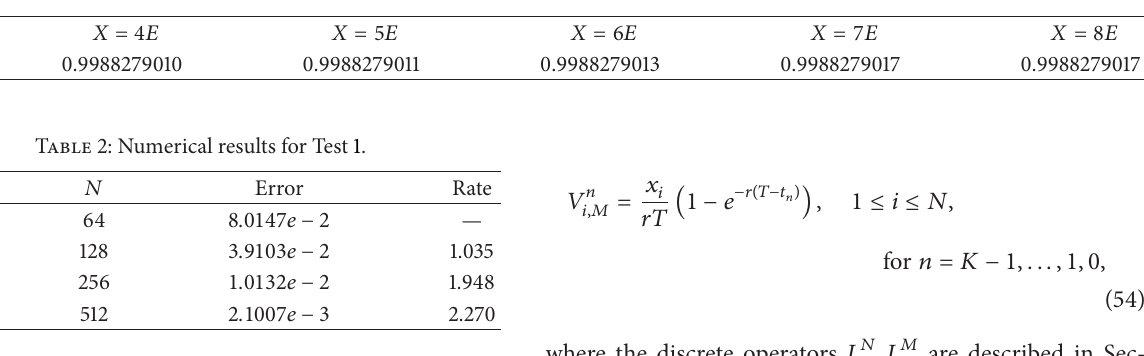
Table 1: Comparison of the results at mesh point (𝐸,𝐾𝑇/2, 0) for different values of 𝑋 for fixed parameters: 𝜎 = 0.2, 𝑟 = 0.08, 𝑇 = 1,𝐸 = 2, 𝑁 = 1024 , and 𝑀 = 𝐾 = 256 .